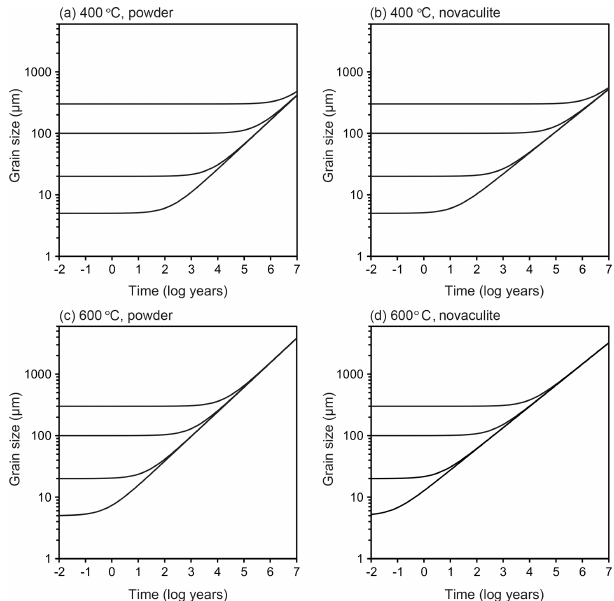
Figure 11. Extrapolation to natural conditions using the grain growth laws obtained from the powder and novaculite samples. Initial grain sizes of 5, 20, 100, and 300µm. ( a–b ) 400 ◦ C. ( c– d ) 600 ◦ C. See text for the settings of other